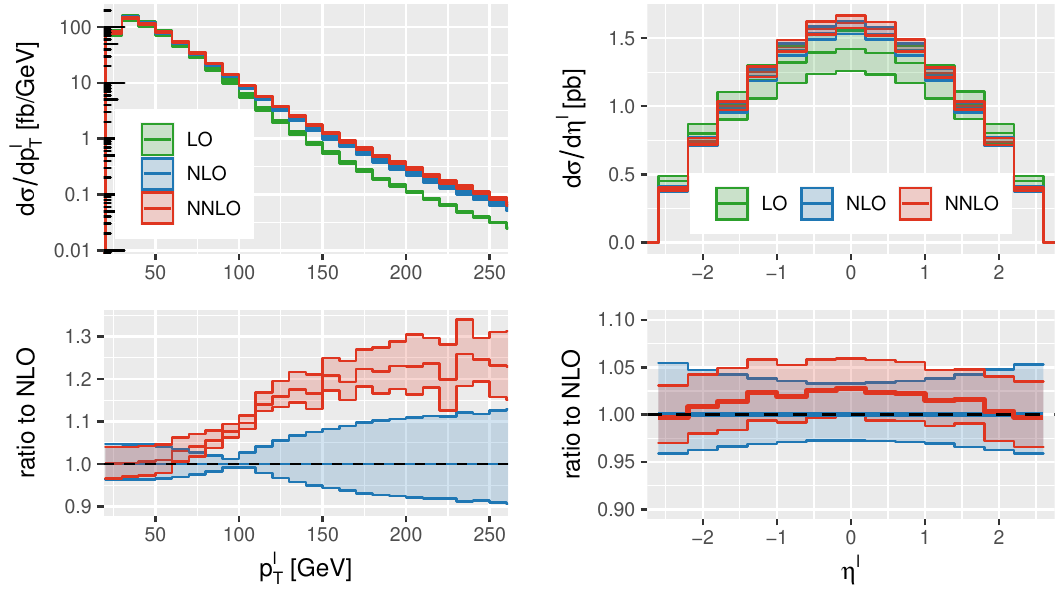
Figure 17 . Positron transverse momentum distribution (left) and pseudorapidity distribution (right).